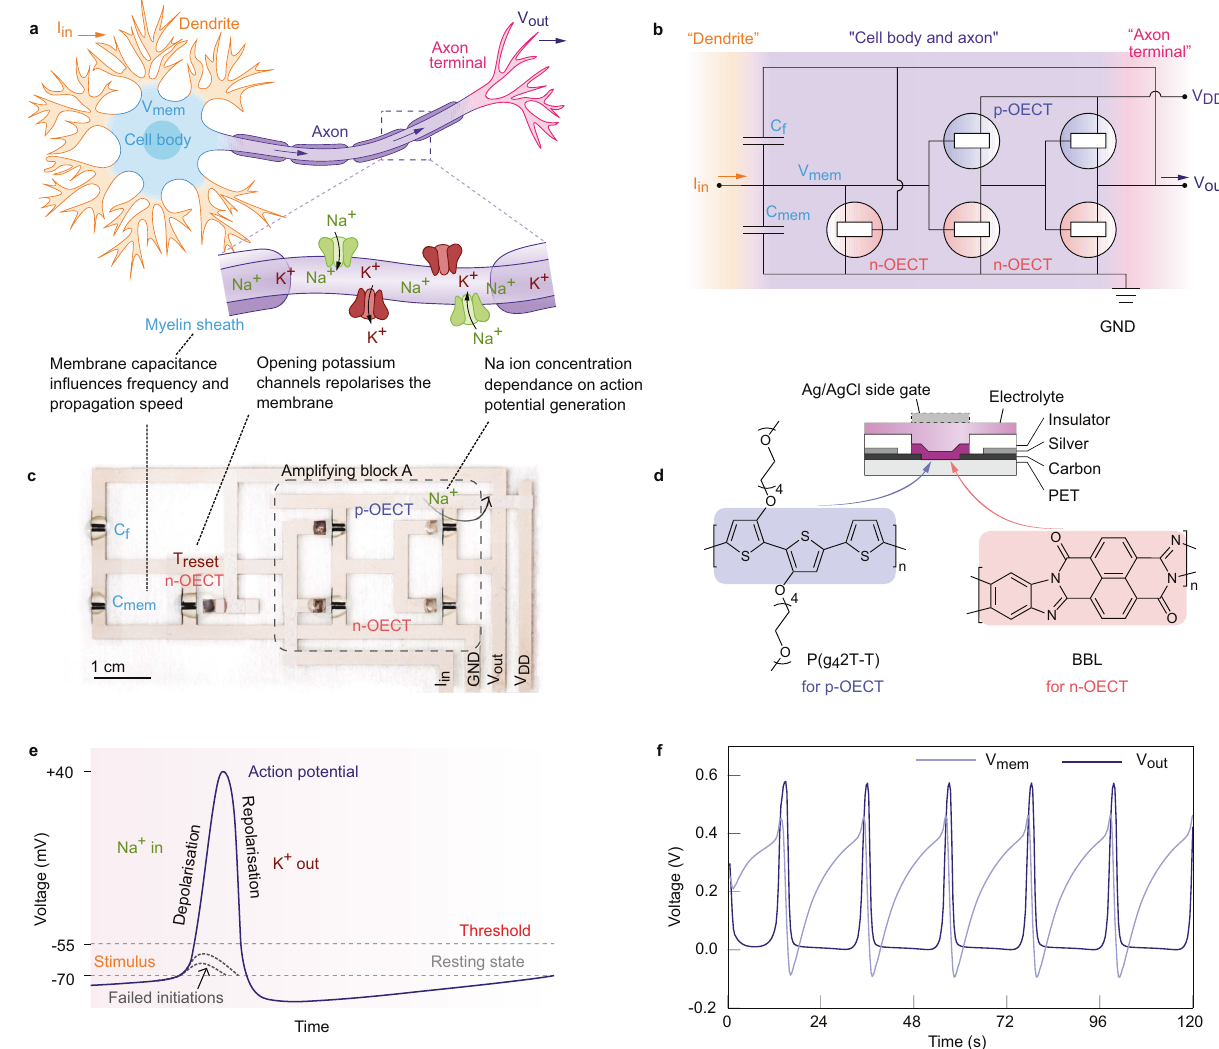
Fig. 1 Organic electrochemical neurons and analogy with the biological neurons. a , b Schematic of the biological neuron and its analogy with the organic electrochemical neuron based on Axon Hillock circuit. c Fully printed organic electrochemical neurons. d Structure of the printed p-type P(g42T-T) and n-type BBL OECTs. e Different phases of the action potential in a nerve cell. f Spiking behaviors of the organic electrochemical neurons